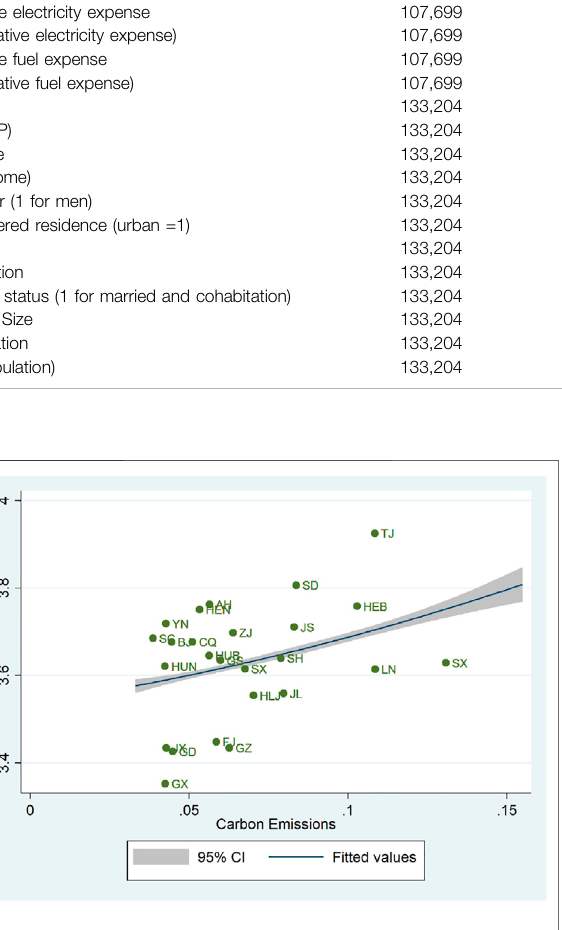
FIGURE 2 | The relationship between carbon emissions and life satisfaction in